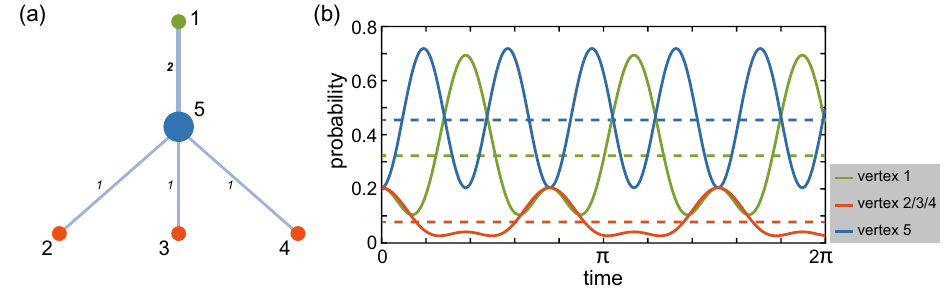
Figure 1. ( a ) A typical 5-node network. ( b ) Probability distribution on each vertex i along the evolution time t , where the three red vertices show identical behaviours. The dotted line denotes the average probability, thus the ( CTQW ) CTQW-based centrality of each vertex c i .